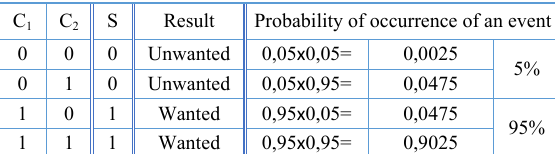
Table 1. Effect on the quality of a decision in the case of a subordinate headed by two chiefs with preference of one chief (C 1 ), in the case of